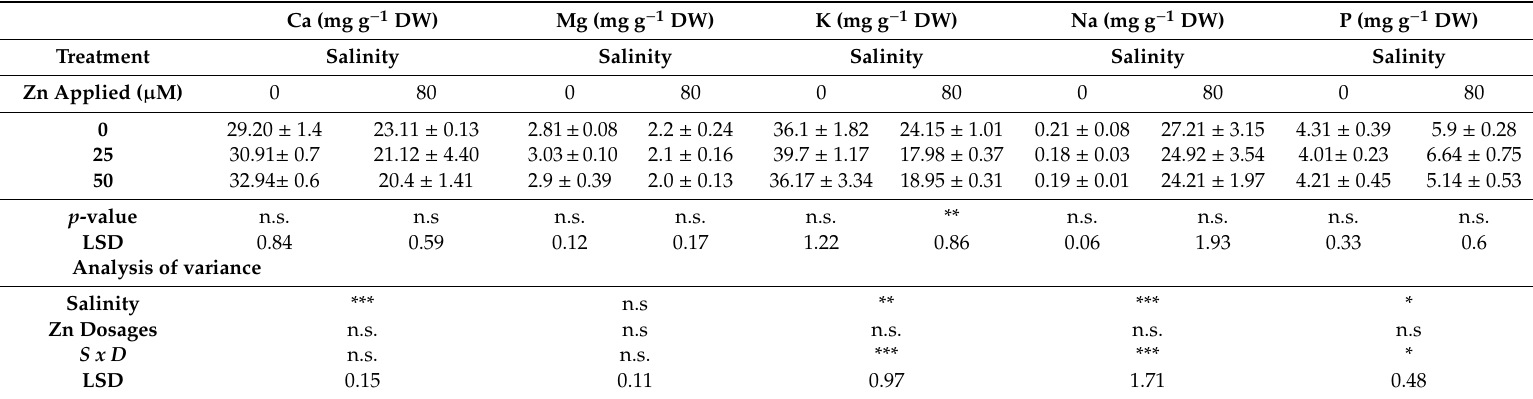
Table 2. Macronutrient concentrations of leaves of pak choi plants grown with di ff erent salinity and / or Zn treatments. Values are means ± SE ( n =